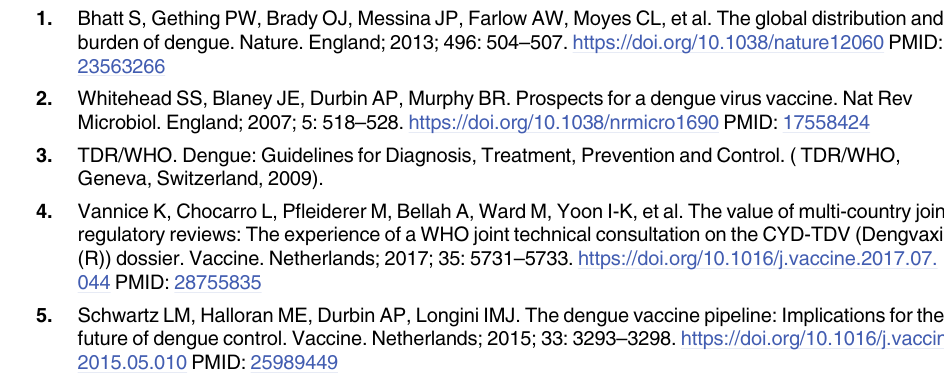
S1 Table. Demographics and the clinical signs and symptoms associated with primary vs secondary DENV infections. S2 Table. Phylogenetic analyses of DENV-1 samples reference sequences. S3 Table. Phylogenetic analyses of DENV-2 samples reference